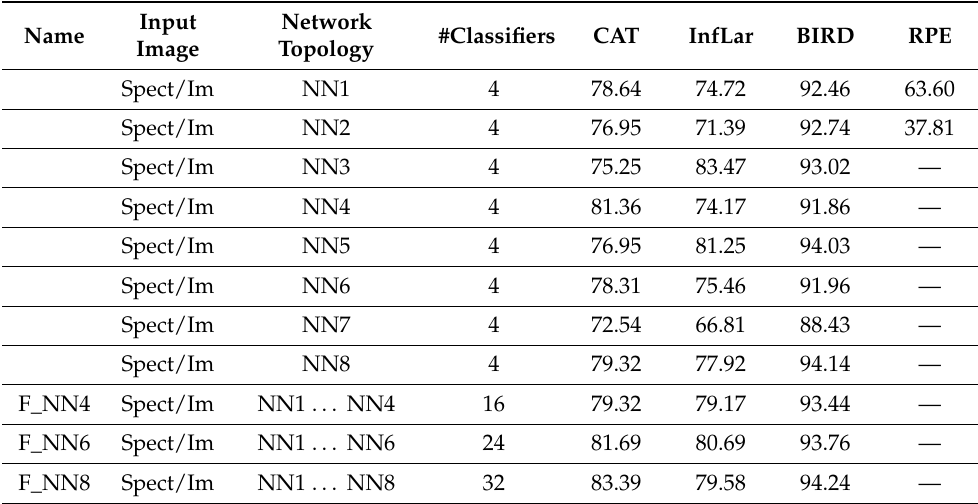
Table 3. Performance accuracy obtained by different network topologies with input image = Spect/Im (note: to reduce computation time and considering the low performance of RPE on Spect/IM (the SNNs do not always converge during training), we only report the performance of NN1 and NN2). Best values are in